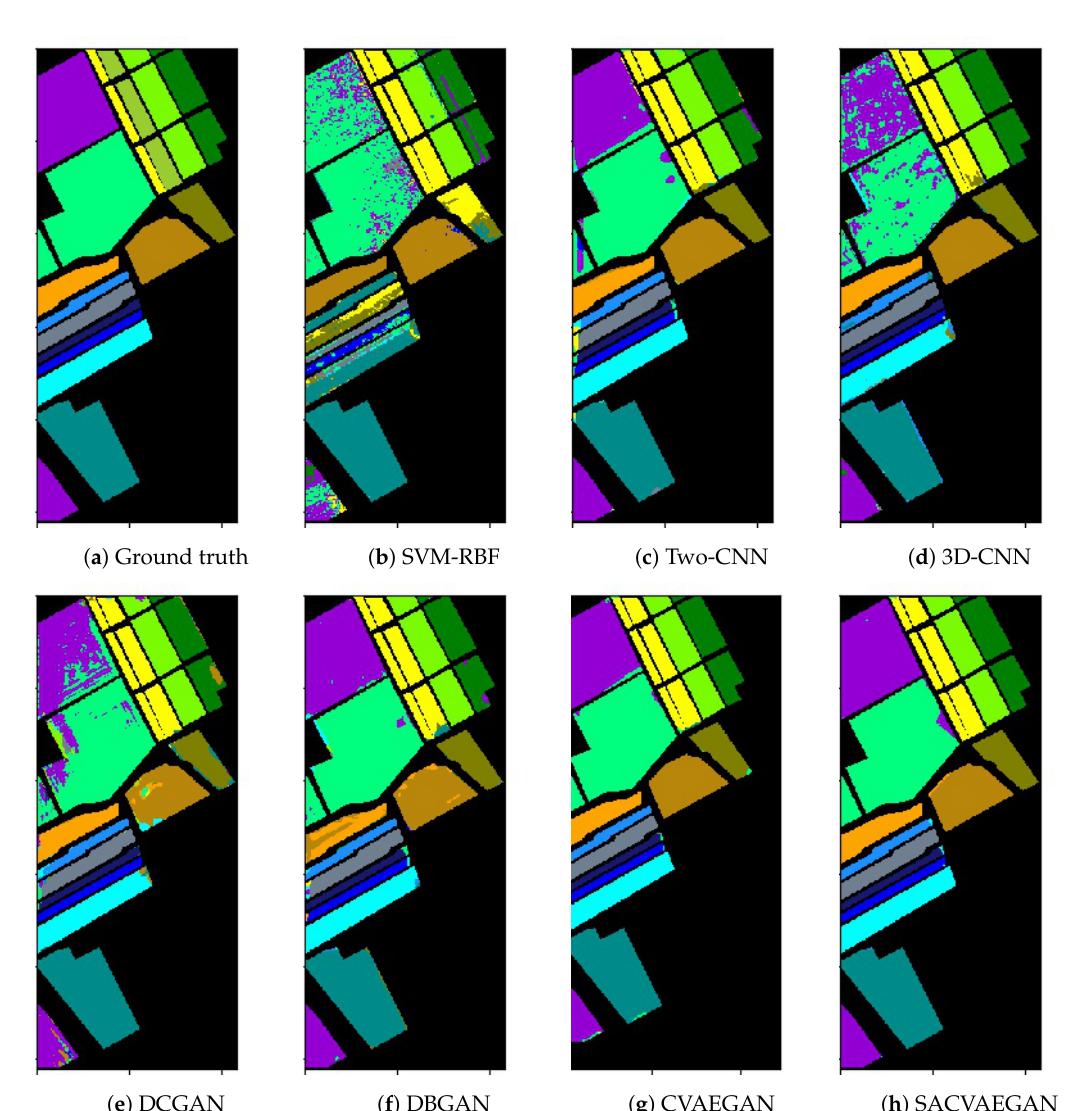
Figure 8. Illustration of the classification results on the PaviaU data set. ( a ) Ground truth, ( b ) SVM-RBF (75.25%), ( c ) Two-CNN (95.79%), ( d ) 3D-CNN (91.05%), ( e ) DCGAN (90.39%), (f) DBGAN (94.13%), ( g ) CVAEGAN (98.49%), and ( h ) SACVAEGAN